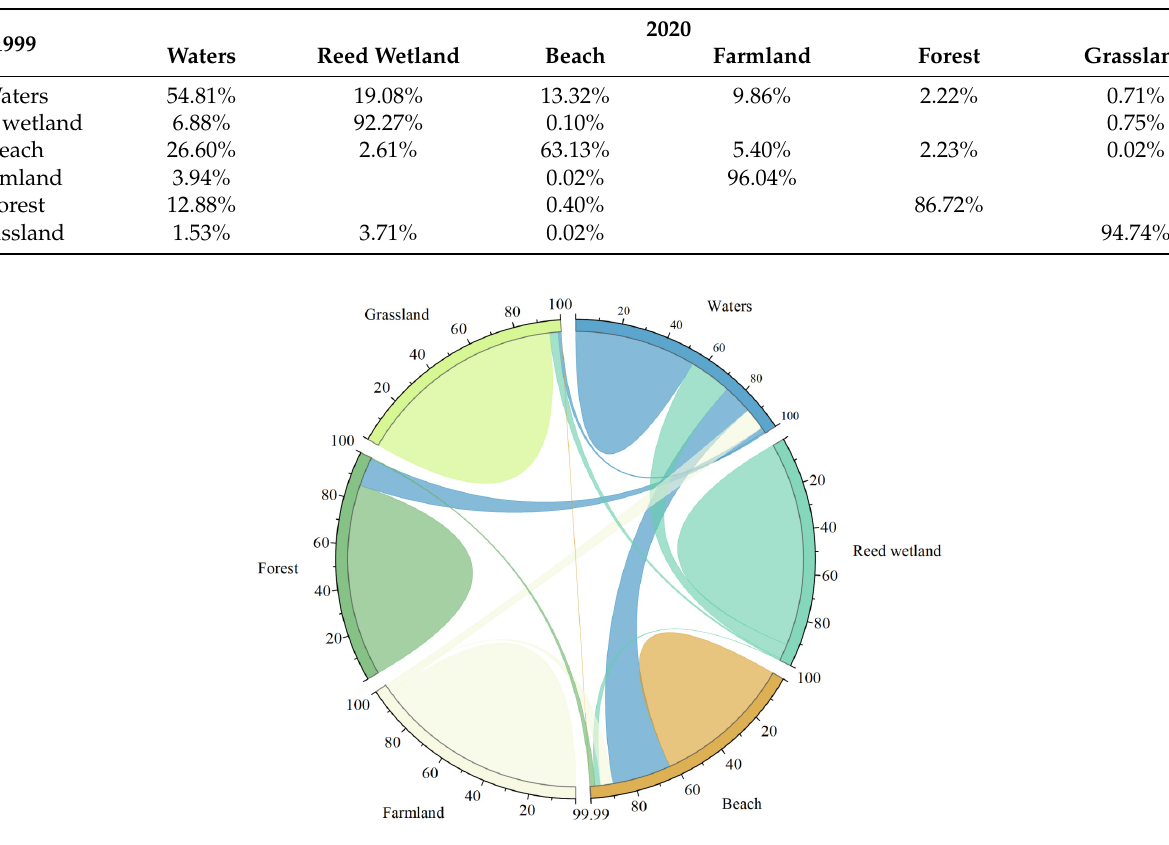
Figure 4. Shifting directions between di ff erent wetland types in the Qingtongxia wetland from 1999 to 2020.